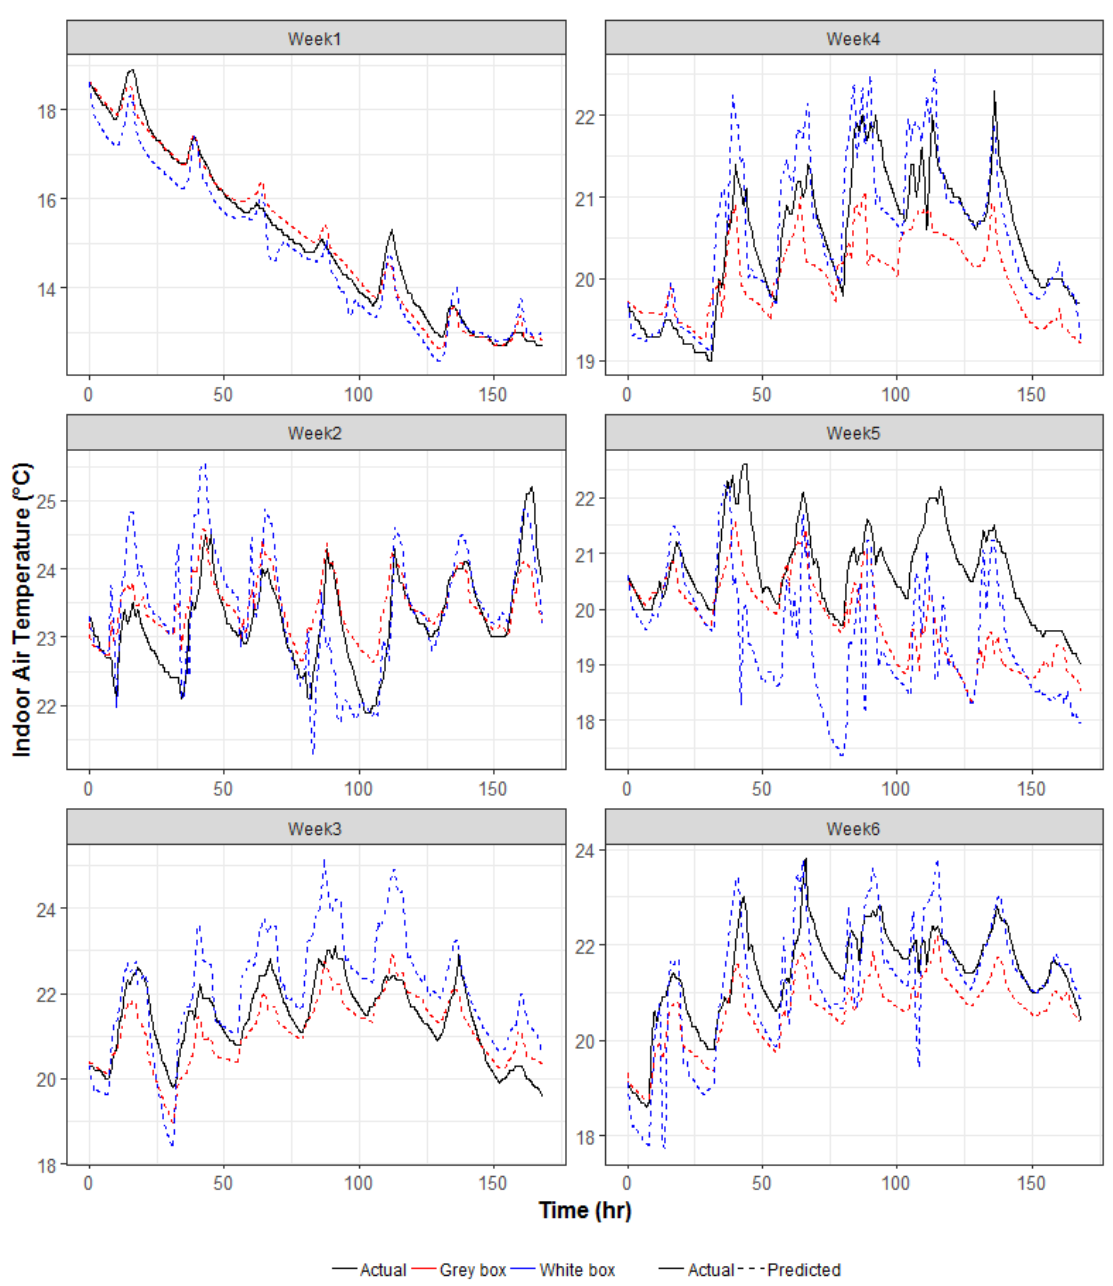
Figure 9. Line graphs of internal air temperature for calibration on weeks 1 to 3 (on the left) and validation on weeks 4 to 6 (on the right), comparing empirical data, GB model predictions (C123_V456) and the WB model predictions.